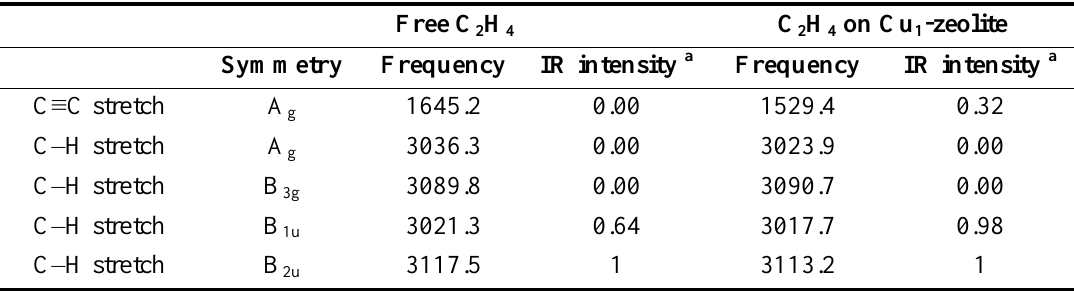
Table 2. Calculated vibrational frequencies (cm -1 ) of CC and CH stretching modes of C before and after the binding into the small monocopper zeolite